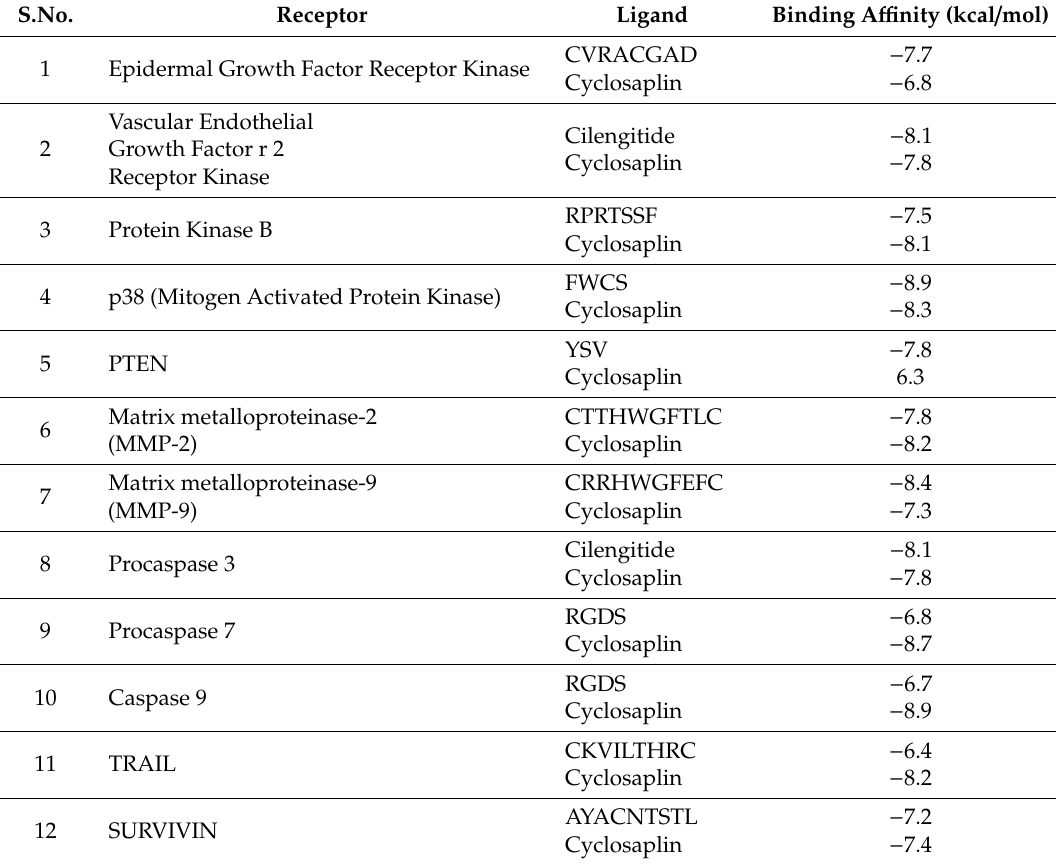
Table 4. Comparative binding a ffi nity of di ff erent ligands with